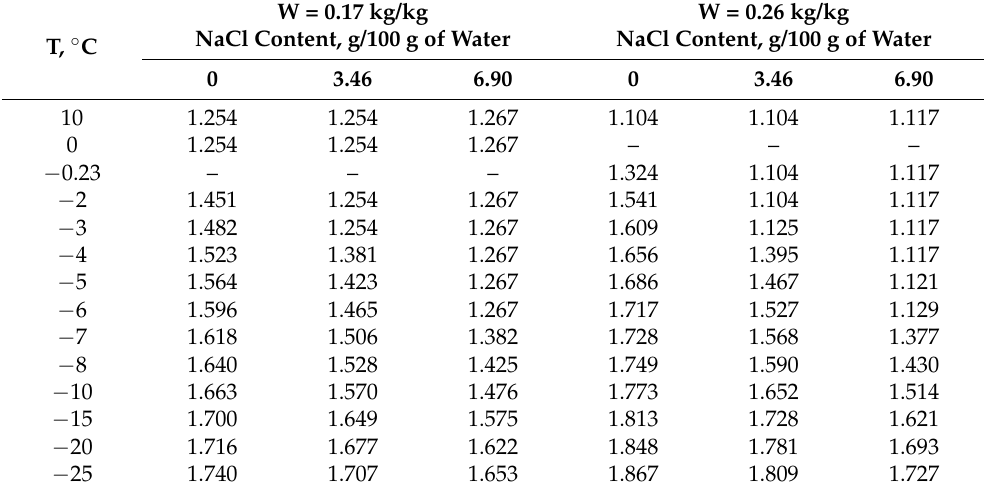
Table 2. Measured heat conductivities (W/(m · ◦ C)) in argillite-like clay at different temperatures and salt concentrations.